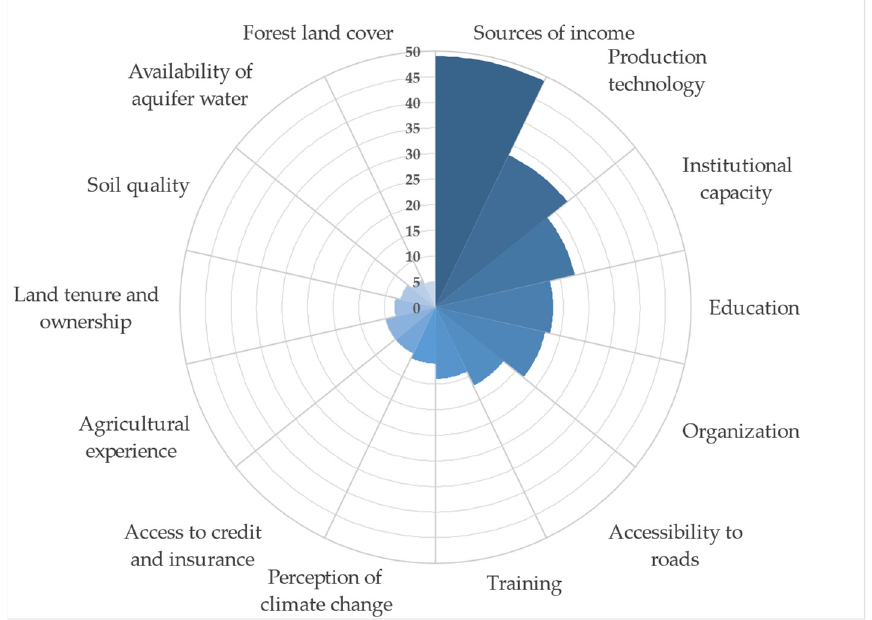
Figure 1. Specific dimensions identified from the coincidence analysis. Source: Based on the studies cited in Table 1.